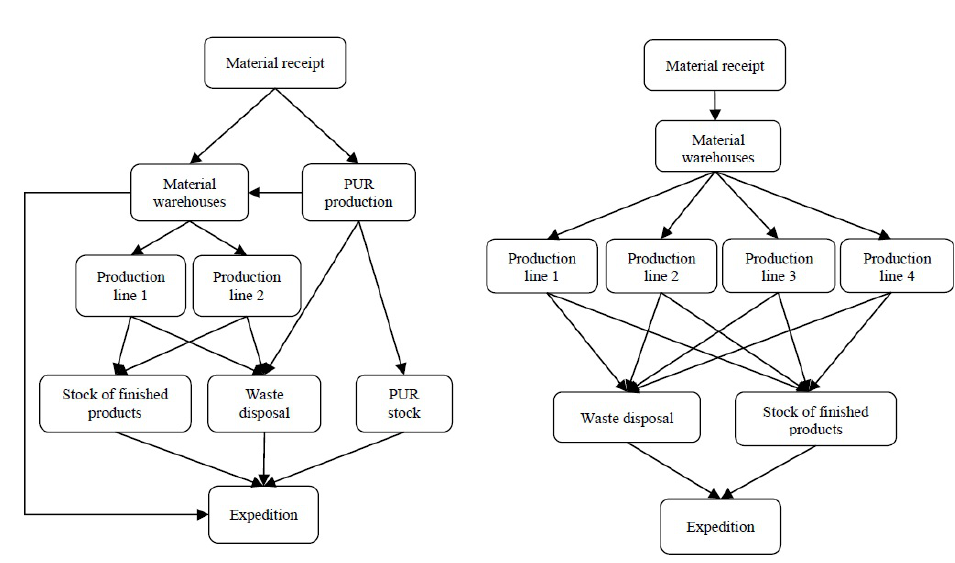
Figure 1: Conceptual models of Plants A and B – original